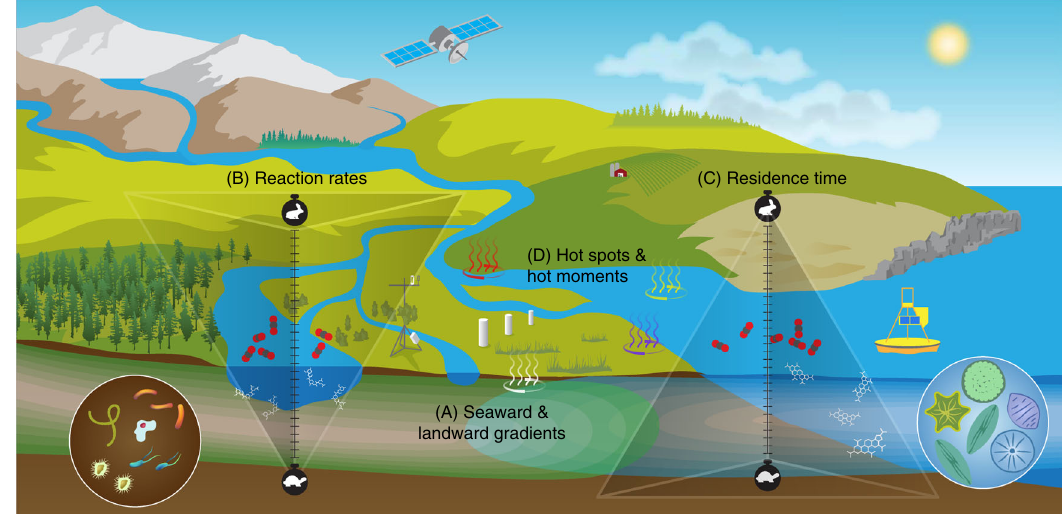
Fig. 3 Biogeochemical characteristics of coastal interfaces. a Two-way exchange of water and materials between terrestrial and marine environments drive gradients in geochemical constituents (e.g., ions, carbon, nutrients), plant distribution, and ecosystem functions (e.g., carbon storage, greenhouse gas emissions, sediment accumulation). b Biogeochemical reaction rates generally occur at more rapid timescales (e.g., hours to days) in aquatic systems such as rivers compared to soils and sediments (years to millennia). c Likewise, the residence time of biogeochemical components is short in aquatic environments such as estuaries and the surface ocean compared to the deep ocean and its sediments. d Coastal interface biogeochemistry is complicated by an abundance of hot spots and moments for diverse reactions across scales that can signi fi cantly alter expected reaction rates and residence